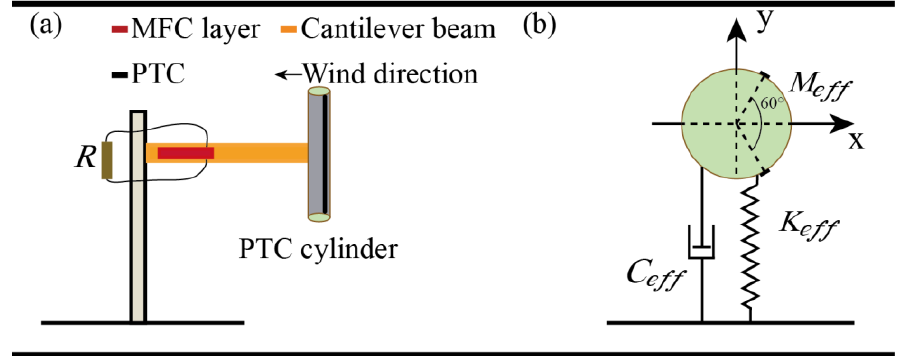
Figure 1. The Galloping based energy harvester with PTC(GEH-PTC): ( a ) The structural diagram; ( b ) the equivalent model.